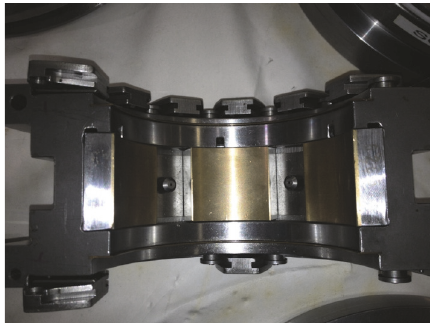
Figure 13: Normal IGT bearing with undamaged tilt pads.